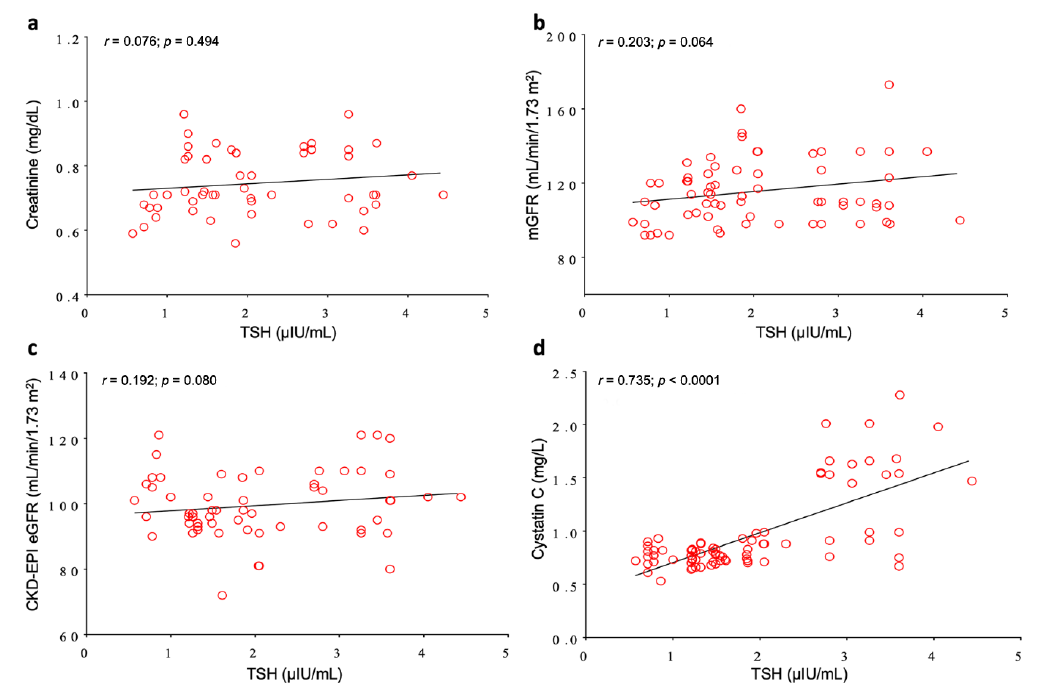
Figure 2. Pearson’s correlation analysis between TSH and renal functional parameters in the total study population. ( a ) TSH vs. creatinine; ( b ) TSH vs. mGFR; ( c ) TSH vs. CKD-EPI eGFR; ( d ) TSH vs. Cystatin C.